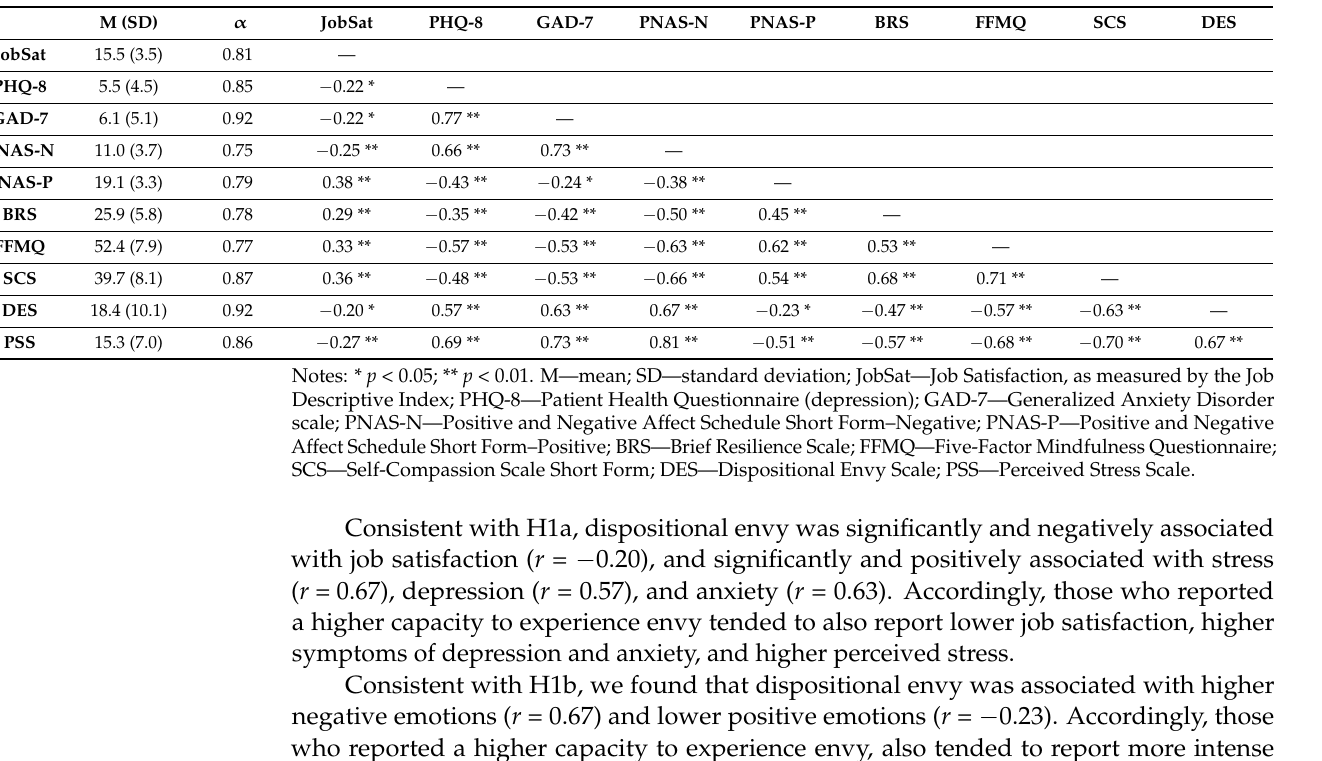
Table 1. Pearson correlations between job attitudes, risk factors, and protective